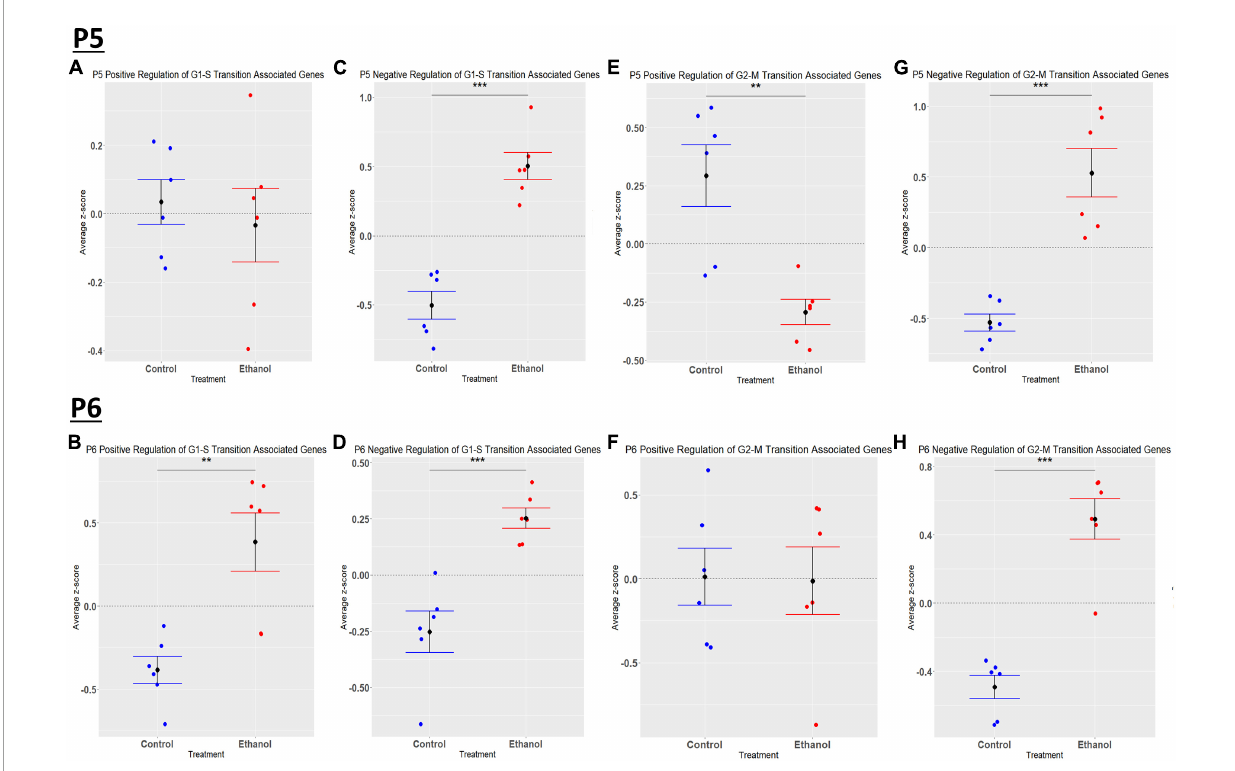
FIGURE10 Ethanol-induced alterations in cell cycle regulation at P5 and P6 in the cerebellum. Gene list associated with positive and negative regulation of G1-S transition and positive and negative regulation of G2-M transition were extracted from the Mouse Genome Database. Genes associated with each cell cycle stage in our dataset at P5 and P6 were extracted as detailed in Methods. R statistical software was utilized to generate individual z-scores for each transcript of interest and each experimental animal. These z-scores were then averaged across transcripts for each individual animal. Quantification by average z-score of positive regulation of G1-S transition associated genes at P5 (A) and P6 (B) , negative regulation of G1-S transition associated genes at P5 (C) and P6 (D) , positive regulation of G2-M transition associated genes at P5 (E) and P6 (F) , and negative regulation of G2-M transition associated genes at P5 (G) and P6 (H) . n = 3 males and 3 females per treatment group E or C; ** p < 0.01, *** p <